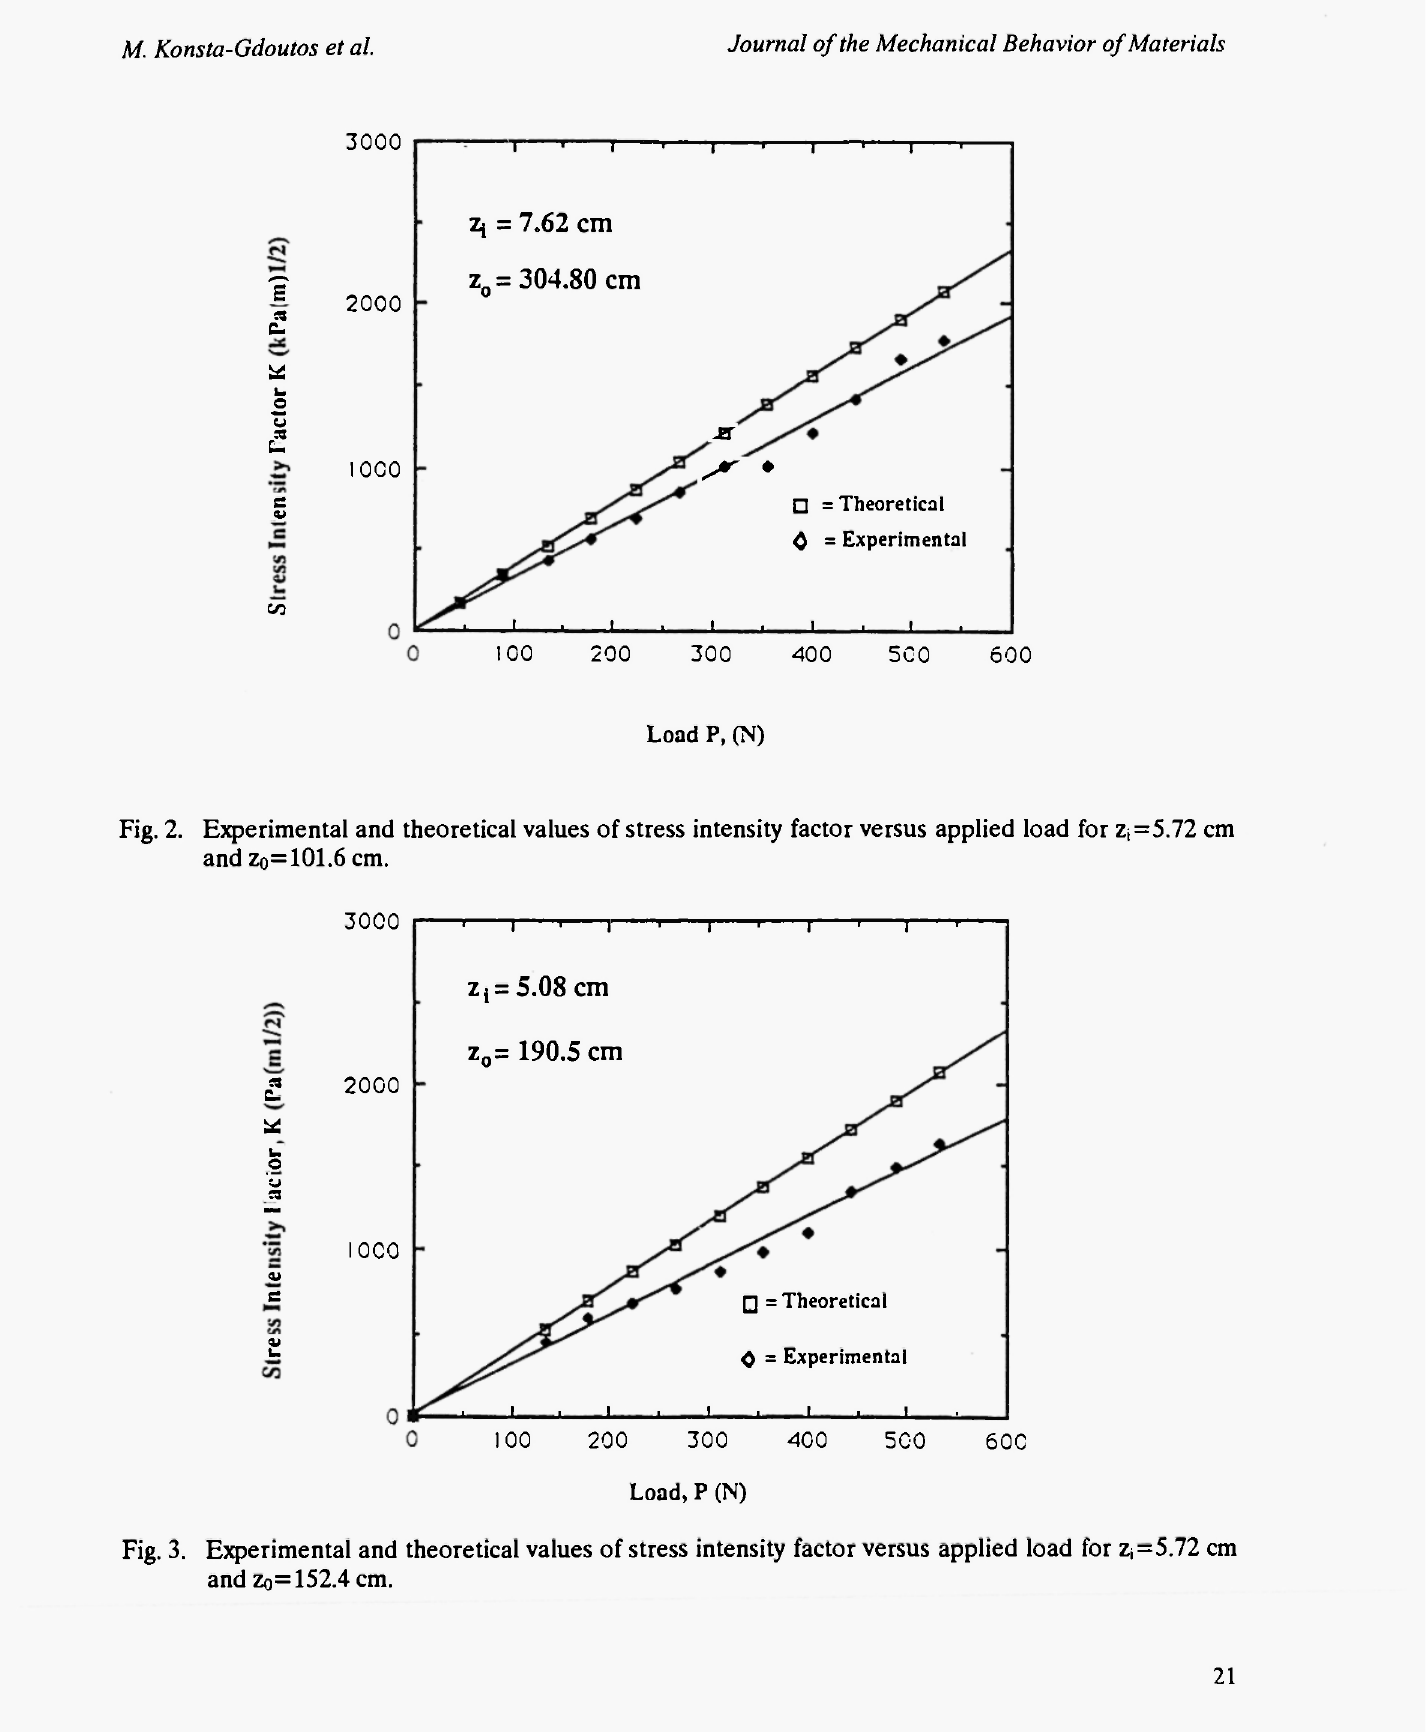
Fig. 3. Experimental and theoretical values of stress intensity factor versus applied load for Zj =5.72 cm and Zo=152.4